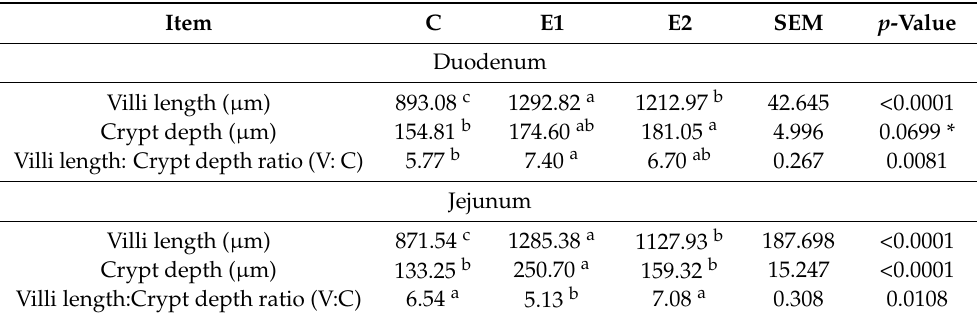
Table 7. Measurements of the villi length and crypt depth for the duodenum and jejunum of experimental groups in comparison with the control